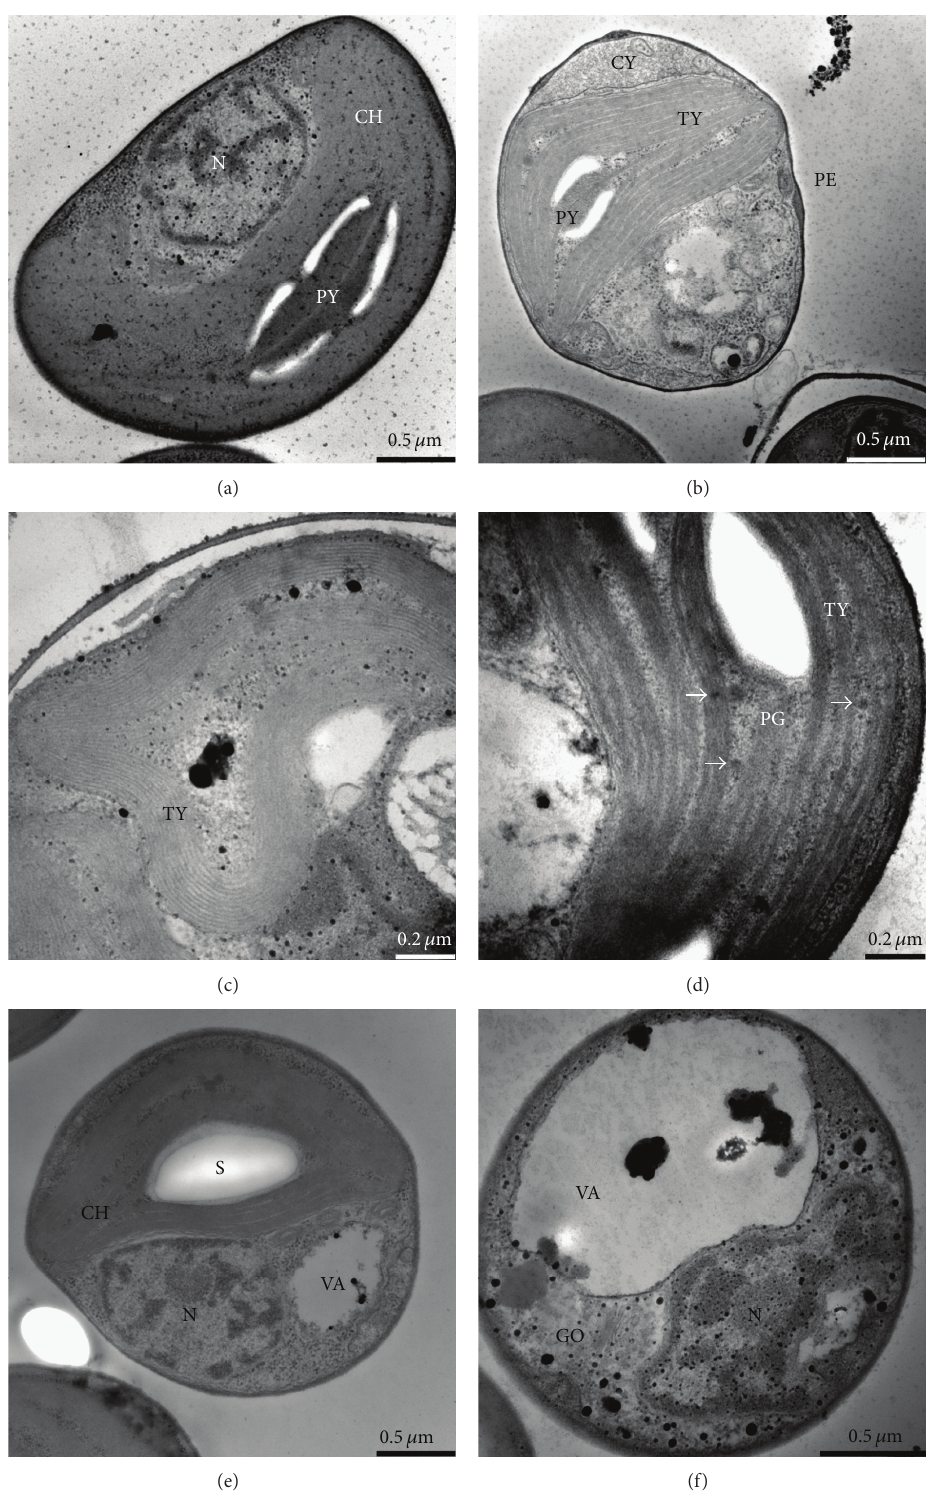
Figure6:Ultrastructureimagesmadebytransmissionelectronmicroscopyof:Se-freesinglecell(a)andcellexposedto40mgL −1 selenate(b); fingerprint-like thylakoids (c) and plastoglobules (indicated by arrows) (d) in cell exposed to 100mgL −1 selenate; autophagy in cell exposed to 40mgL −1 selenate (e, f); CH: chloroplast; CY: cytoplasm; CW: cell wall; N: nucleus; PE: periplasm; PG: plastoglobules; PY: pyrenoid; TY: thylakoids; VA: autophagic vacuole; and V: